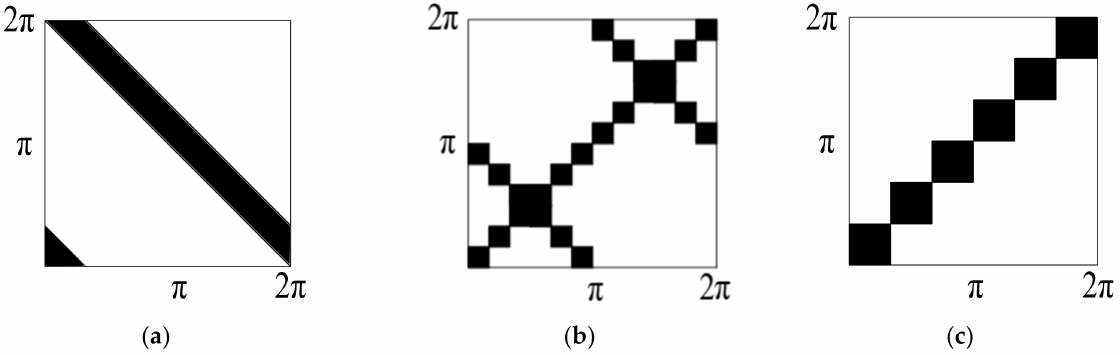
Figure 6. Shapes of the conduction areas proposed in this research: ( a ) “crossing point”, ( b ) “as close as possible”, and ( c ) “two closest” approaches (derived by authors in